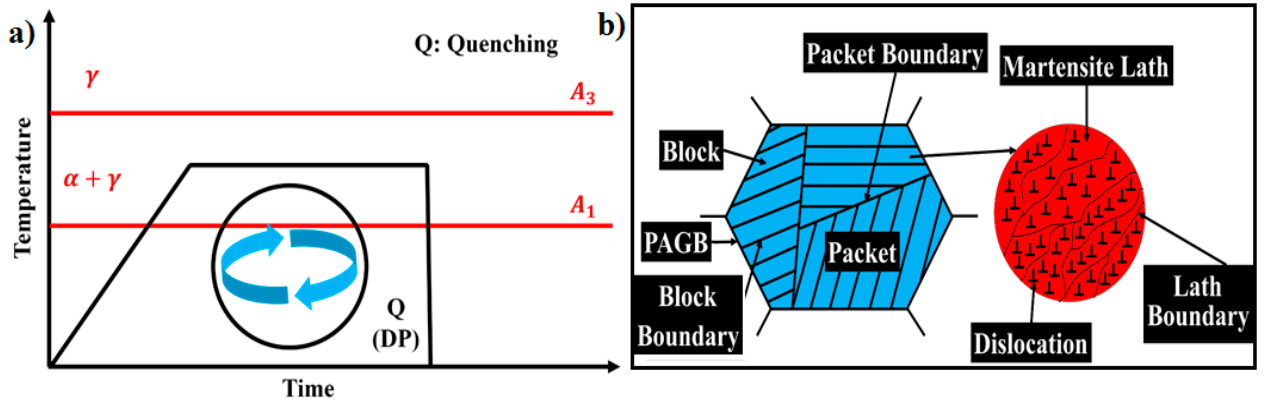
Figure 4. ( a ) Heat treatment regime (processing route 1) for FGS reduction. ( b ) The schematic structure of lath martensite phase. PAGB = prior austenite grain boundary [3]. Reprinted with permission from ref. [3]. Copyright 2021